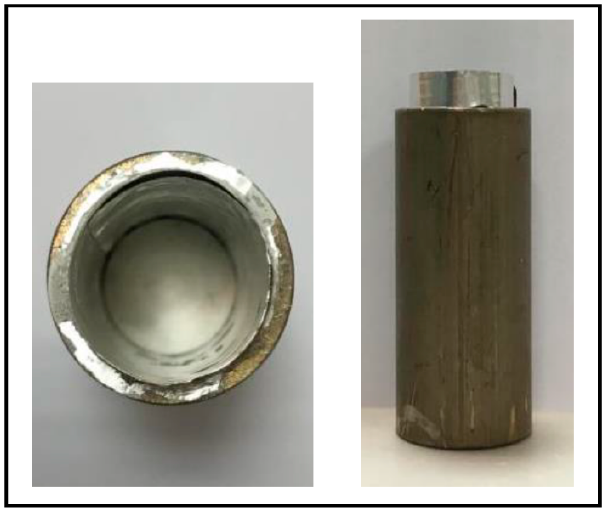
Figure 4. Prepared tablet inserted in a thick aluminum sheet, and a mold on a stainless steel base ready to be foamed.